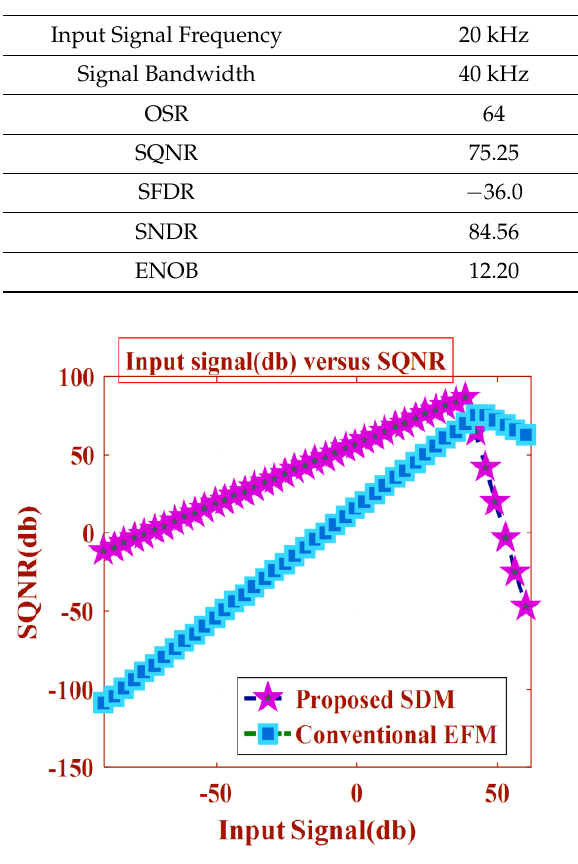
Table 1. Comparison of conventional 2nd order EFM and Hybrid MASH-EFM.